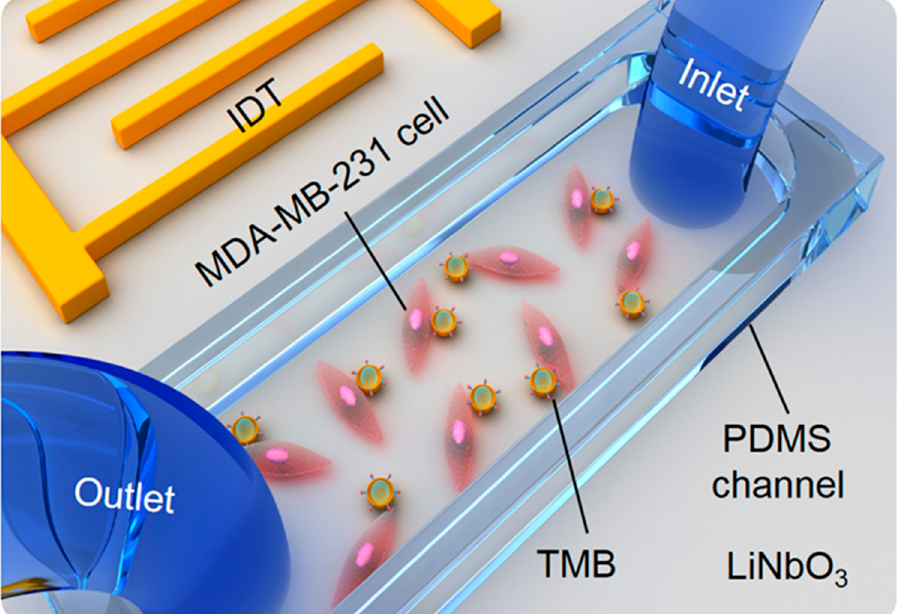
Figure 1. Schematic of the experimental device. The MDA-MB-231 cells were cultured in a PDMS channel, and the TMBs adhered to cells. The TSAW was applied to excite TMBs for cell sono ‐ poration.